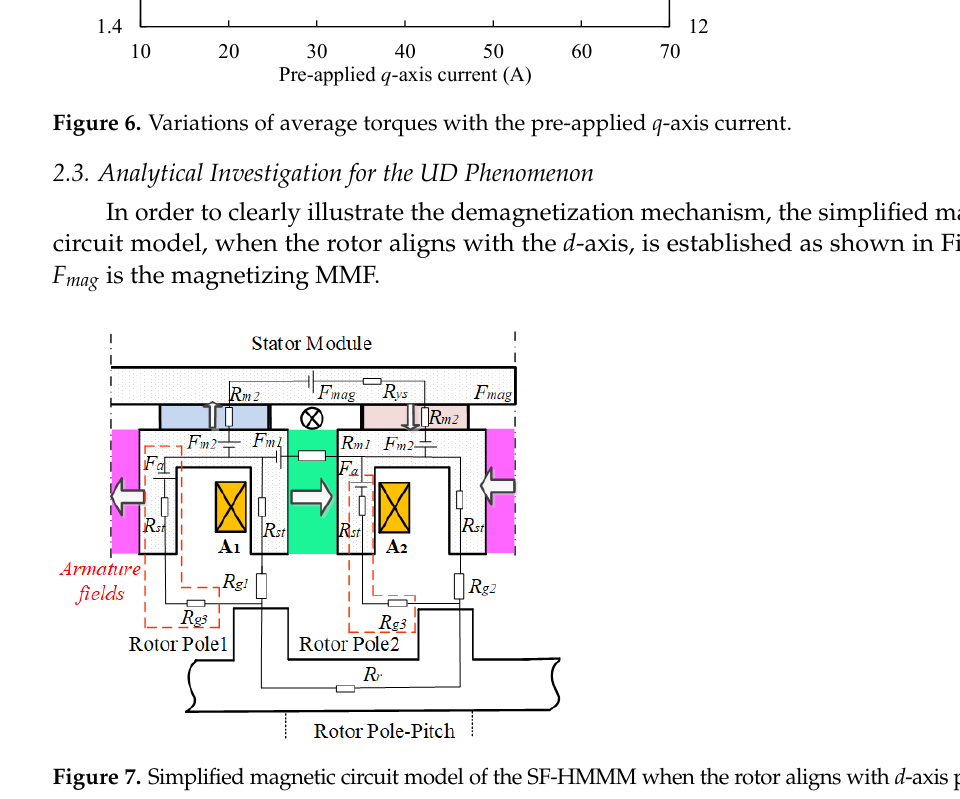
Figure 7. Simplified magnetic circuit model of the SF-HMMM when the rotor aligns with d -axis position. For the open-circuit condition, the fringing flux leakage is ignored for simplicity, i.e., the bypass air-gap magnetic reluctance R g3 is assumed to be infinite. Consequently, the maximum open-circuit air-gap flux Φ δ + can be obtained by synthesizing individual magnet excited cases, based on the superimposition method, namely: